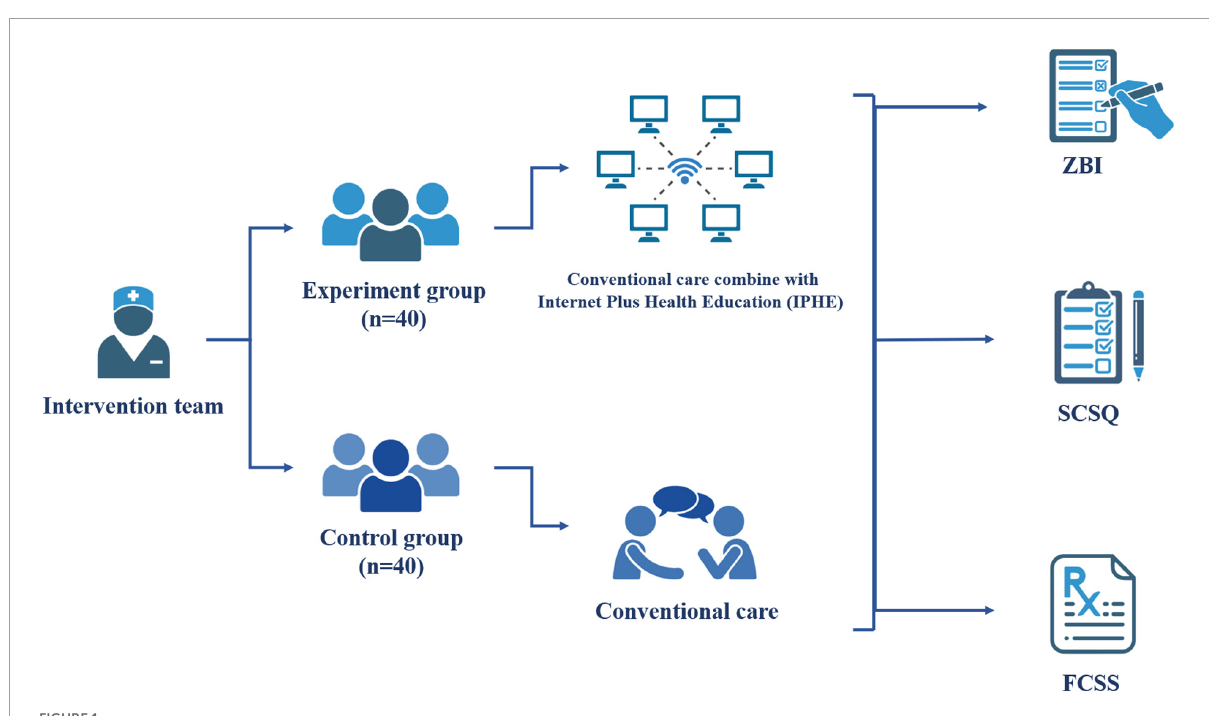
FIGURE1 The experimental flow chart of this study. Made using